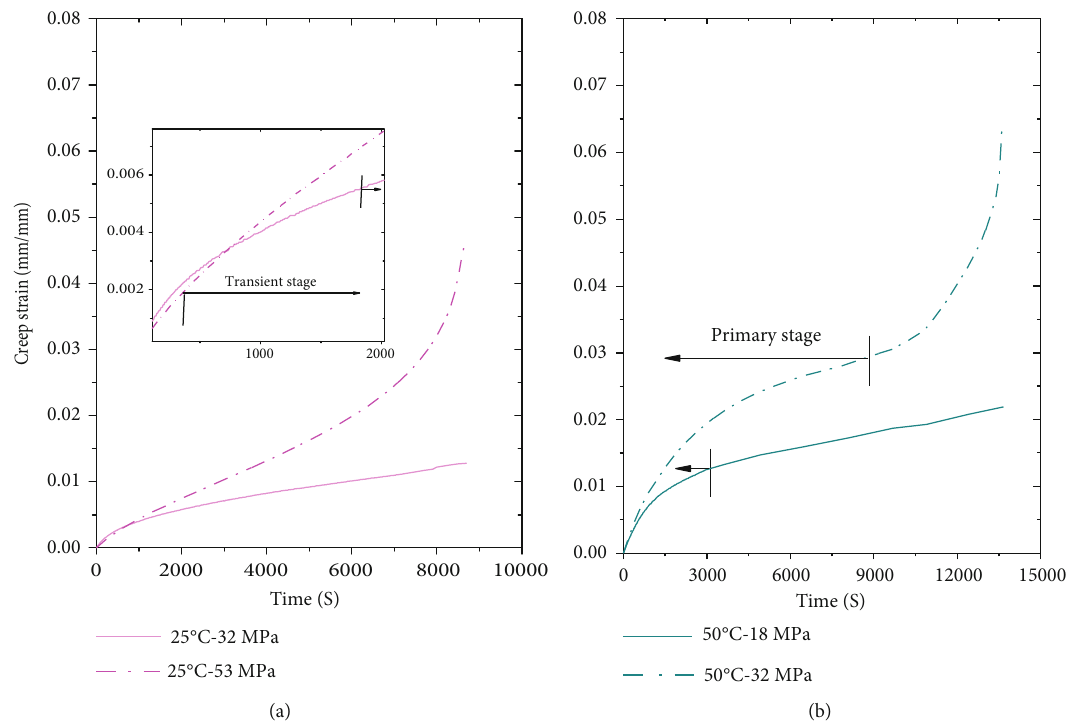
Figure 5: Schematic format of creep failure for neat epoxy (a) at room temperature (32 and 53MPa) and (b) at the glass transition temperature (18 and 32 MPa).